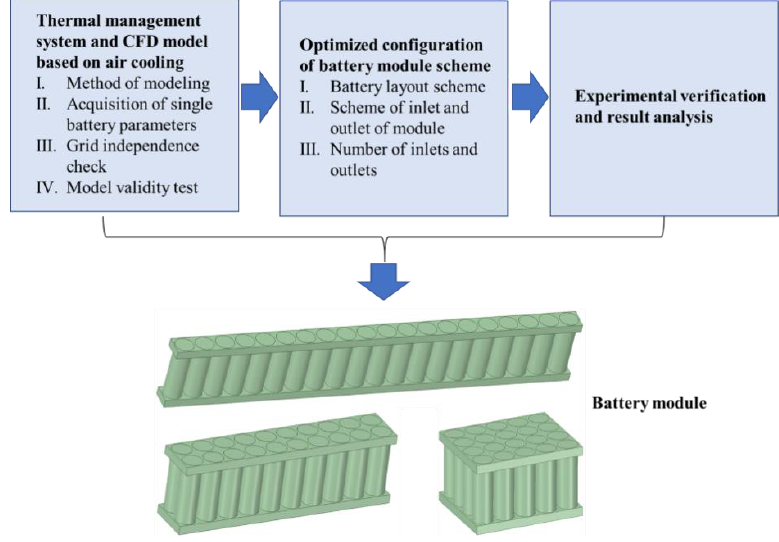
Figure 2. Research methods and the technical route.